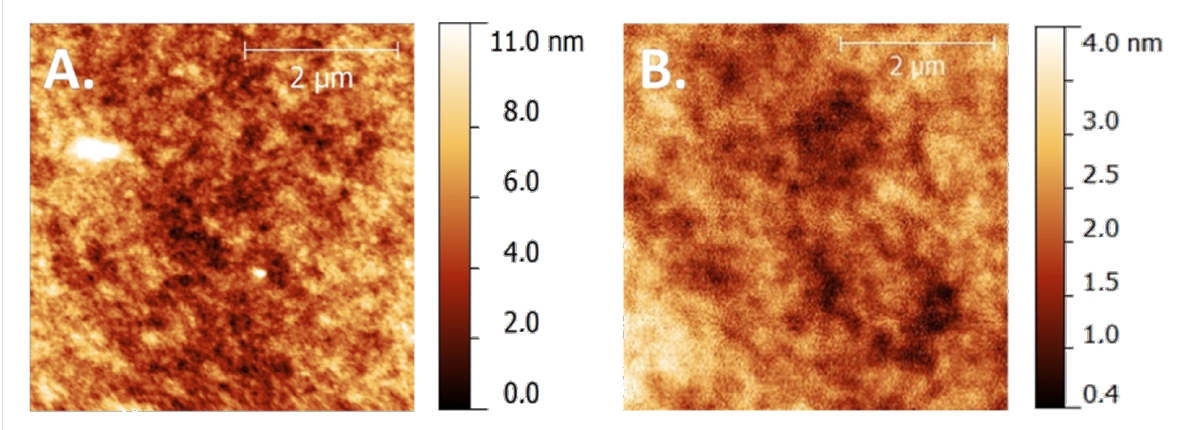
Figure 5: AFM images (size: 5 µm × 5 µm) of: A) 1:2 (wt/wt) PTzBDT-1:PC 61 BM (RMS of ~1.5 nm) and, B) 1:1 (wt/wt) PTzBDT-2:PC 61 BM (RMS of ~0.5 nm) blends.